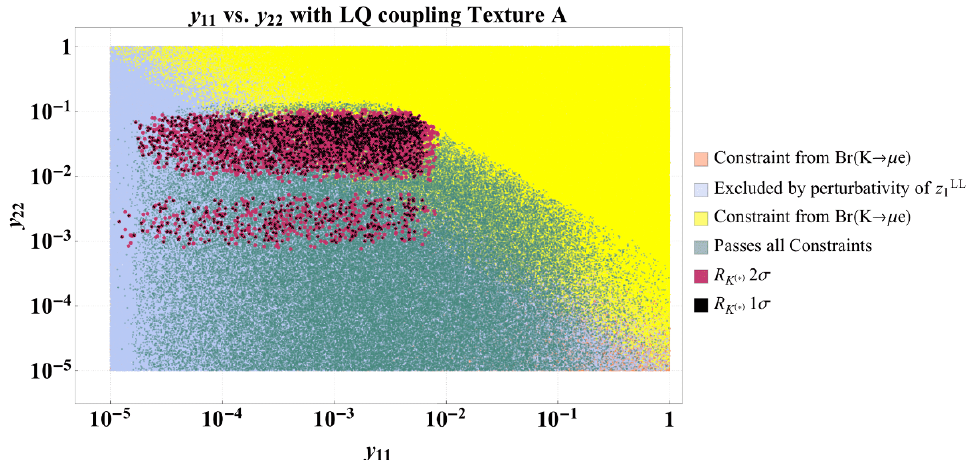
Figure 14 . Indicative plot of the allowed parameter space in the y 22 vs. y 11 plane, for leptoquark coupling matrix Texture A. The yellow section is ruled out by Br( K ! (cid:22)e ), the orange section is ruled out by Br( (cid:22) ! e ) Au , while the teal region is allowed parameter space; speci(cid:12)cally it passes all constraints discussed in section 3 as well as perturbativity constraints on the diquark coupling constants z LL . The light blue region is excluded by perturbativity constraints on diquark 1 ij